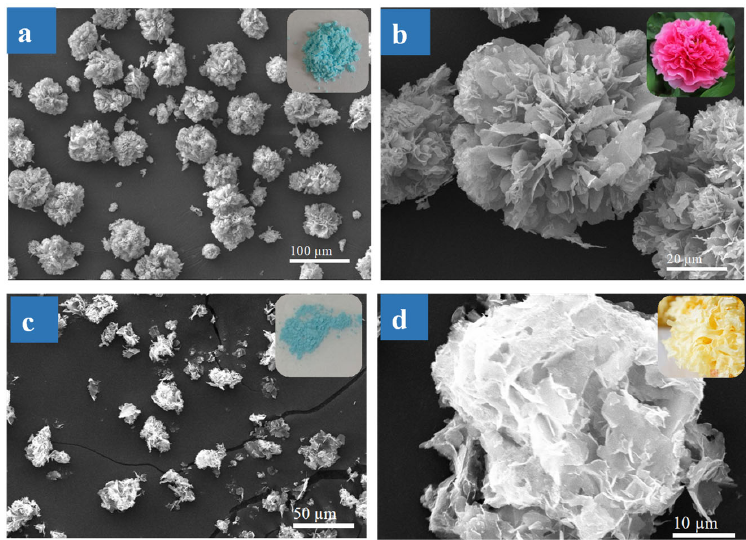
Figure 1. ( a ) and ( b ) SEM images of SF@Cu ‐ NFs product with SF. Insets are photographies of SF@Cu ‐ NFs and Chinese penoy flower. ( c ) and ( d ) SEM images of Cu 3 (PO 4 ) 2 particles without SF. Insets are photographies of Cu 3 (PO 4 ) 2 particles and Chinese tremella.